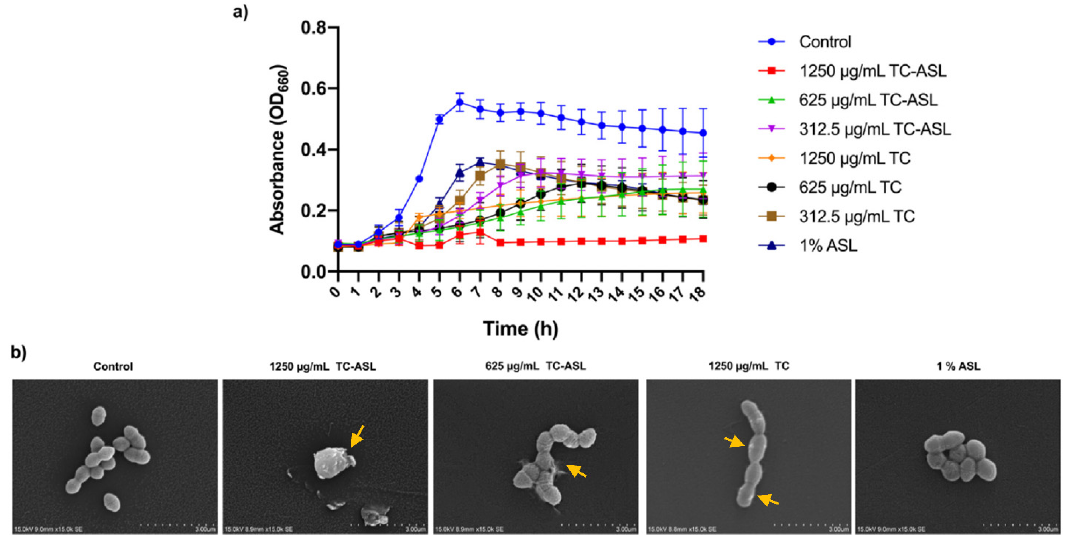
Figure 2. Time–kill kinetics of TC–ASL, TC, and ASL against planktonic E. faecalis . ( a ) 2 × 10 6 CFU/mL of planktonic E. faecalis was treated with 1250, 625, and 312.5 μ g/mL of TC, the respective concentrations of TC mixed with 1% ASL, or pristine 1% ASL for 18 h at 37 °C. At each hour, the absorbance was recorded, and the graph depicts the time-dependent effects of these treatment groups against E. faecalis . ( b ) Membrane-disruptive ability: SEM images show the loss of bacterial membrane integrity and shrinkage of the cells in the 1250, 625 μ g/mL TC–ASL groups, whereas intact membrane was observed in the control, Pristine TC, and ASL alone groups. This indicates that the mechanism of action of TC–ASL to kill the cells is membrane disruption. The yellow arrows indicate changes in the bacterial cell membrane following treatment.